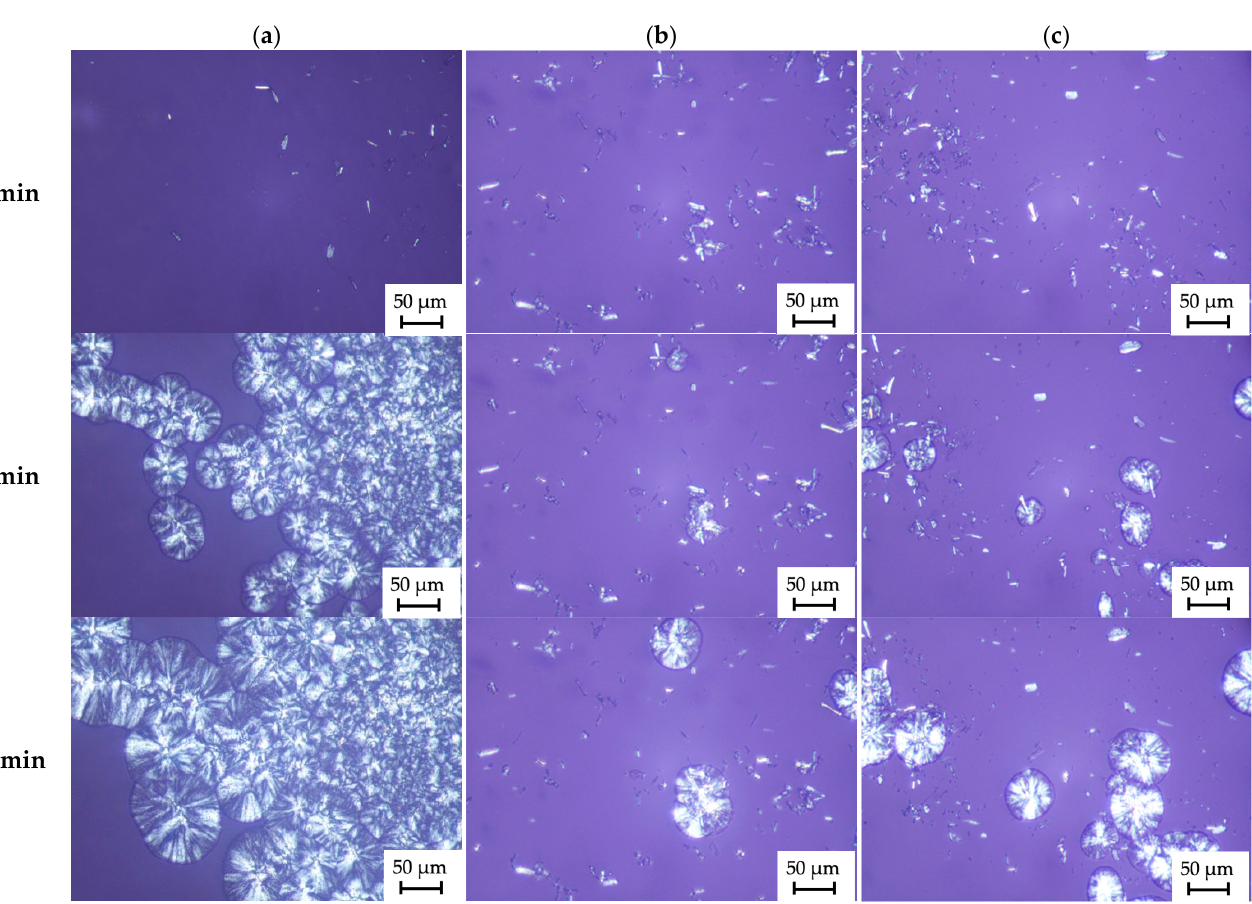
Figure 8. Optical microscope images of polymer nanocomposites ( a ) PP+C, ( b ) PP+C-IL1, ( c ) PP+C-IL2.